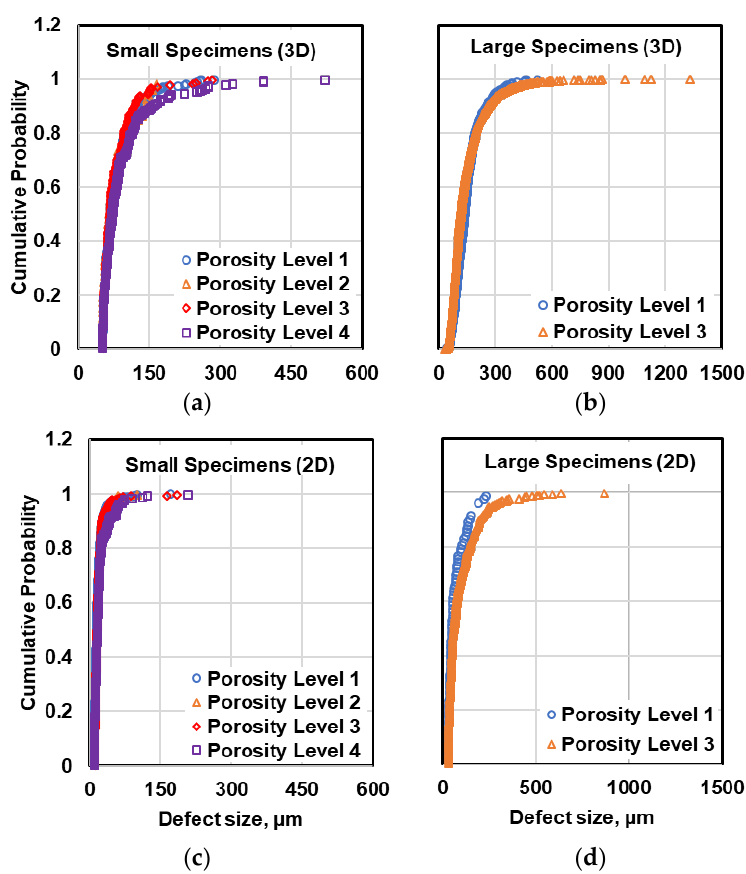
Figure 8. Comparison of defect distribution in different porosity levels measured by X-ray radiography in small and large specimens based on ( a , b ) µCT data and ( c , d ) metallography data.